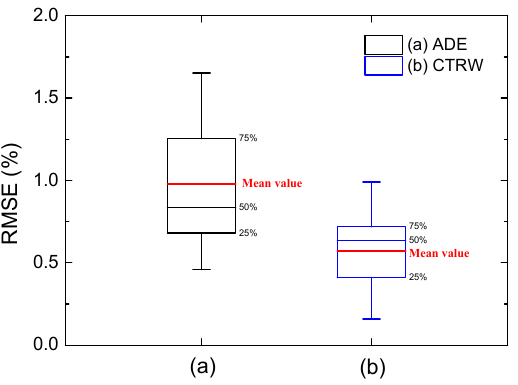
Figure 19. Boxplots of the root mean square error (RMSE) of the BTCs between the numerical